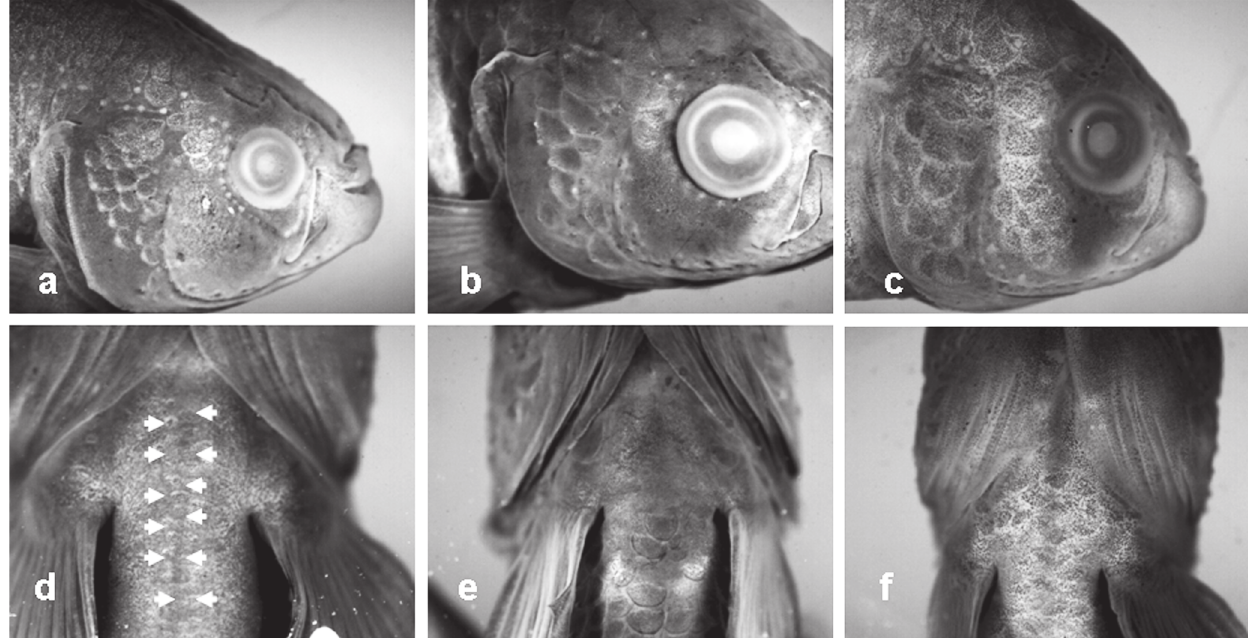
Fig. 3. Squamation pattern in head and abdomen of males. a and d , Austrolebias quirogai (ZVC-P 8725, 38.2 mm SL); b and e , A . gymnoventris (ZVC-P 8708, 33.4 mm SL); c and f , A . luteoflammulatus (ZVC-P 4105, 39.4 mm SL). Arrows indicate scales